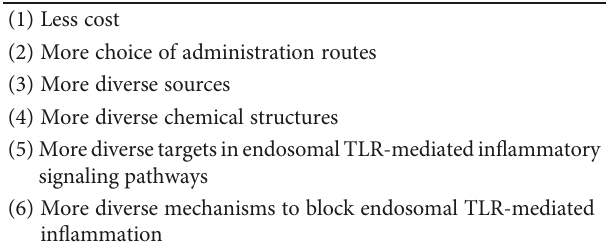
Table 2: Key points of natural modulator in inhibition of psoriatic skin in fl